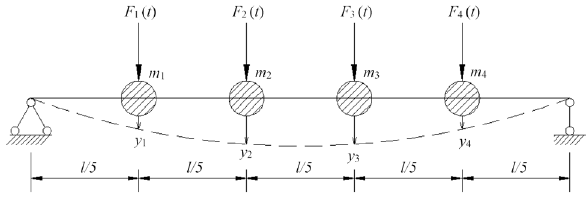
Fig. 7 Dynamic model of single-line pumping unit of LD27-2 WHPB platform